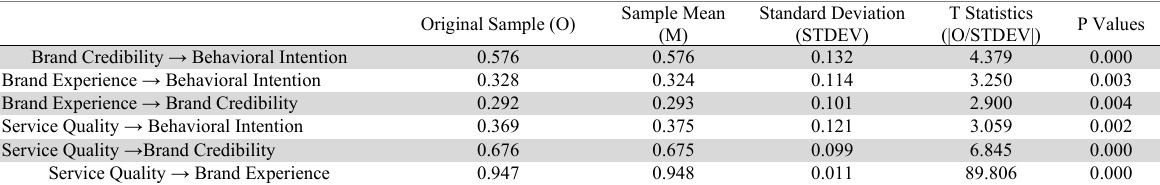
Sample Mean Standard Deviation T Statistics Original Sample (O) P Values (M) (STDEV) (|O/STDEV|)